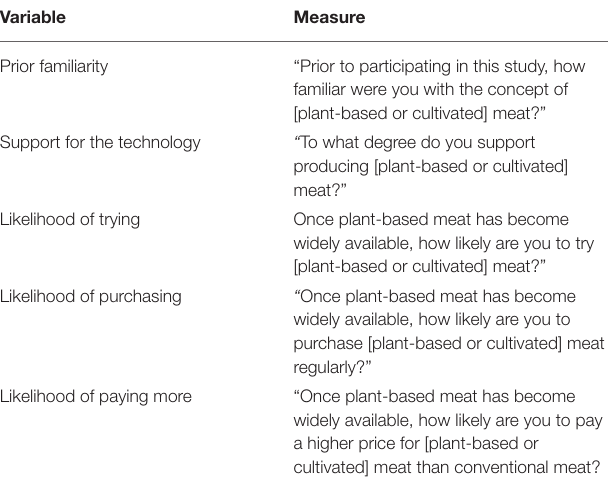
TABLE 1 | Measurement of familiarity and adoption variables.